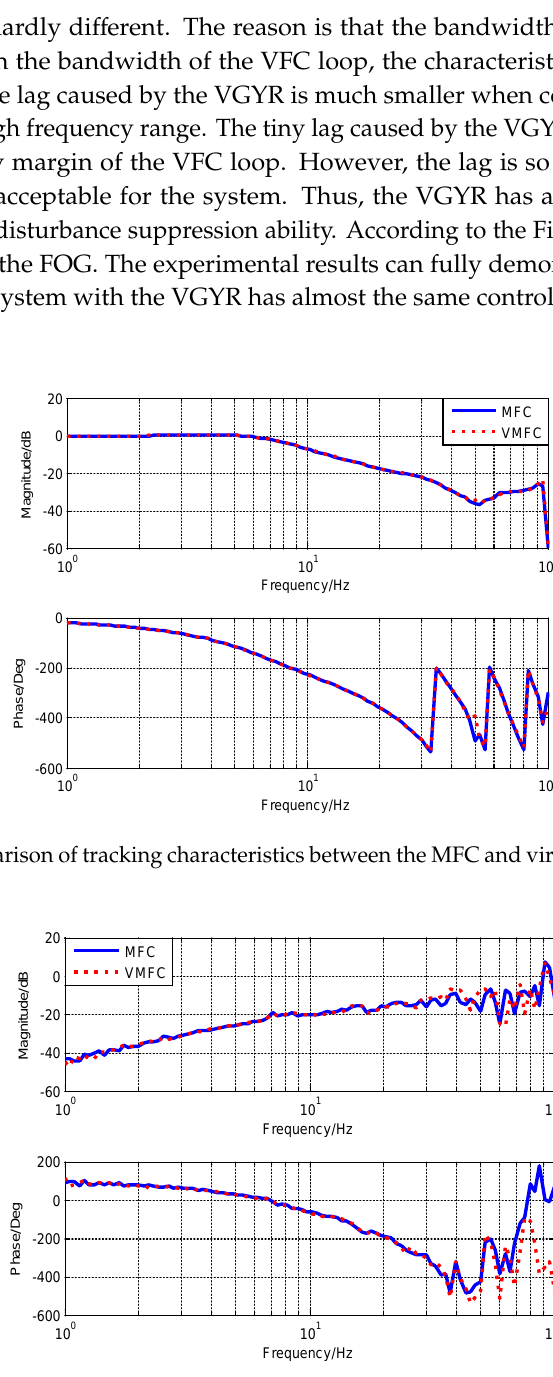
Figure 11. The comparison of disturbance suppression abilities between the MFC and VMFC.